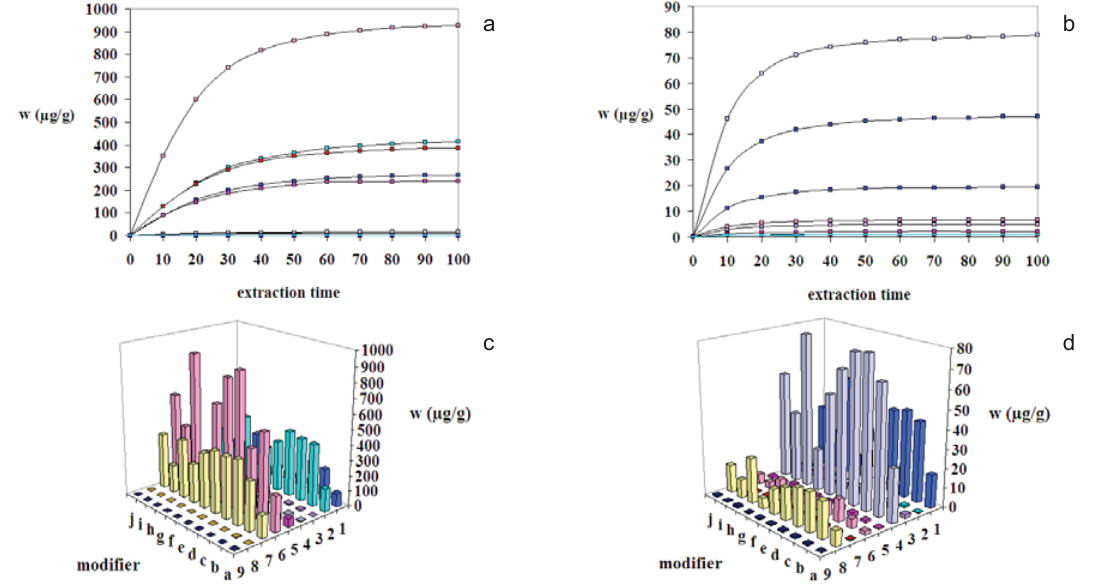
Figure 5. Optimization of extraction time (a, b) and modifier (c, d) in needles P. pungens and leaves J. regia